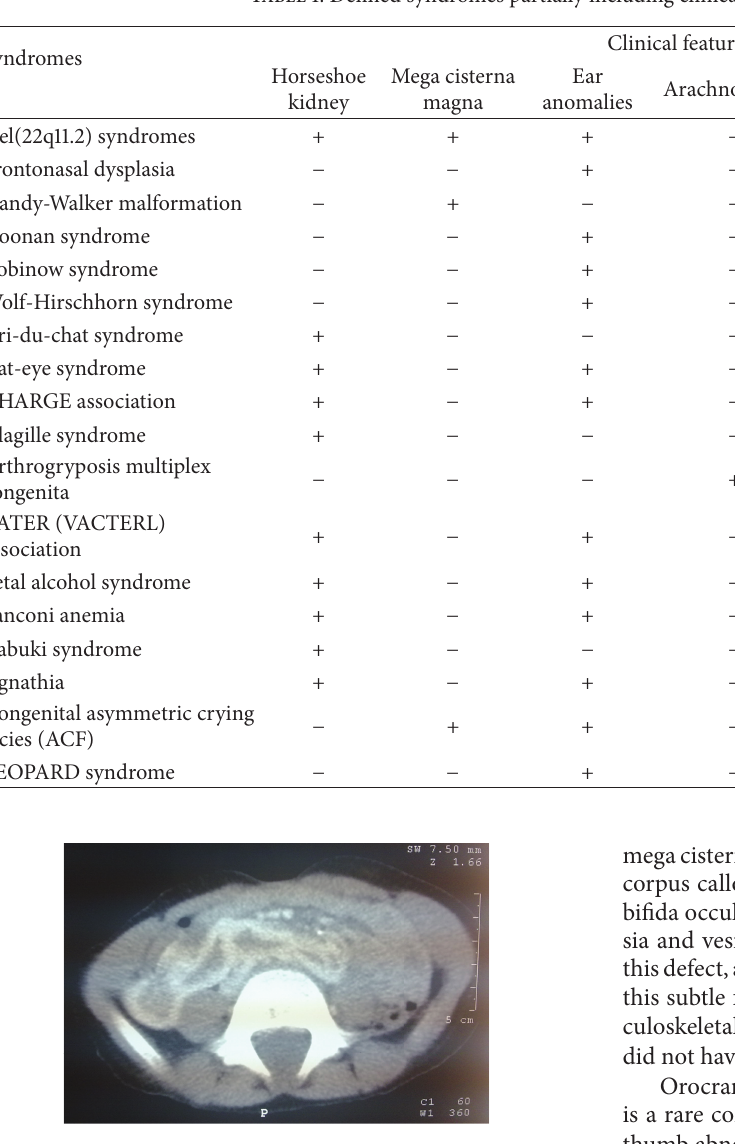
Figure 5: The presence of horseshoe kidney in abdominal ultra-